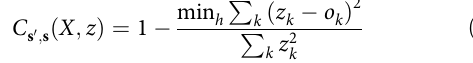
Fig. 2 Nonlinear information processing with a generic reservoir. The targets, indicated by solid lines, are functions of the input s with elements s k ∈ [ − 1, 1], where k indicates the timestep. Given the input the reservoir is trained to produce output that approximates the target as well as possible. In all panels the output is formed from h x R k i , i.e., the reservoir fi rst moments at timestep k . In panels a and b two different encodings (in the magnitude ∣ α ∣ and phase arg ð α Þ of a coherent state) are compared, the trained readout function h is linear and the target are normalized Legendre polynomials P d of degree d 1 in a and 5 in b of the input. Encoding in the magnitude of displacement allows to reproduce only the linear target ð P 1 Þ k ¼ s k while phase encoding has good performance with ð P 5 Þ k ¼ ð 15 s k (cid:2) 70 s 3 k þ 63 s 5 k Þ = 8, con fi rming that some nonlinear tasks are possible with linear h . In panels c and d the encoding is fi xed to ∣ α ∣ but h is a polynomial of the reservoir fi rst moments whose degree is varied (both quadratic and quartic polynomials are considered). The target is the parity check task (PC@ τ = 1 and 3 in c and d , respectively), which requires products of the input elements at different delays τ . Increasing the degree allows the task to be solved at increasingly long delays. In all cases a network of N = 8 oscillators is used and the reservoir output is compared to target for 50 timesteps after training (see Methods for details about the used networks and their